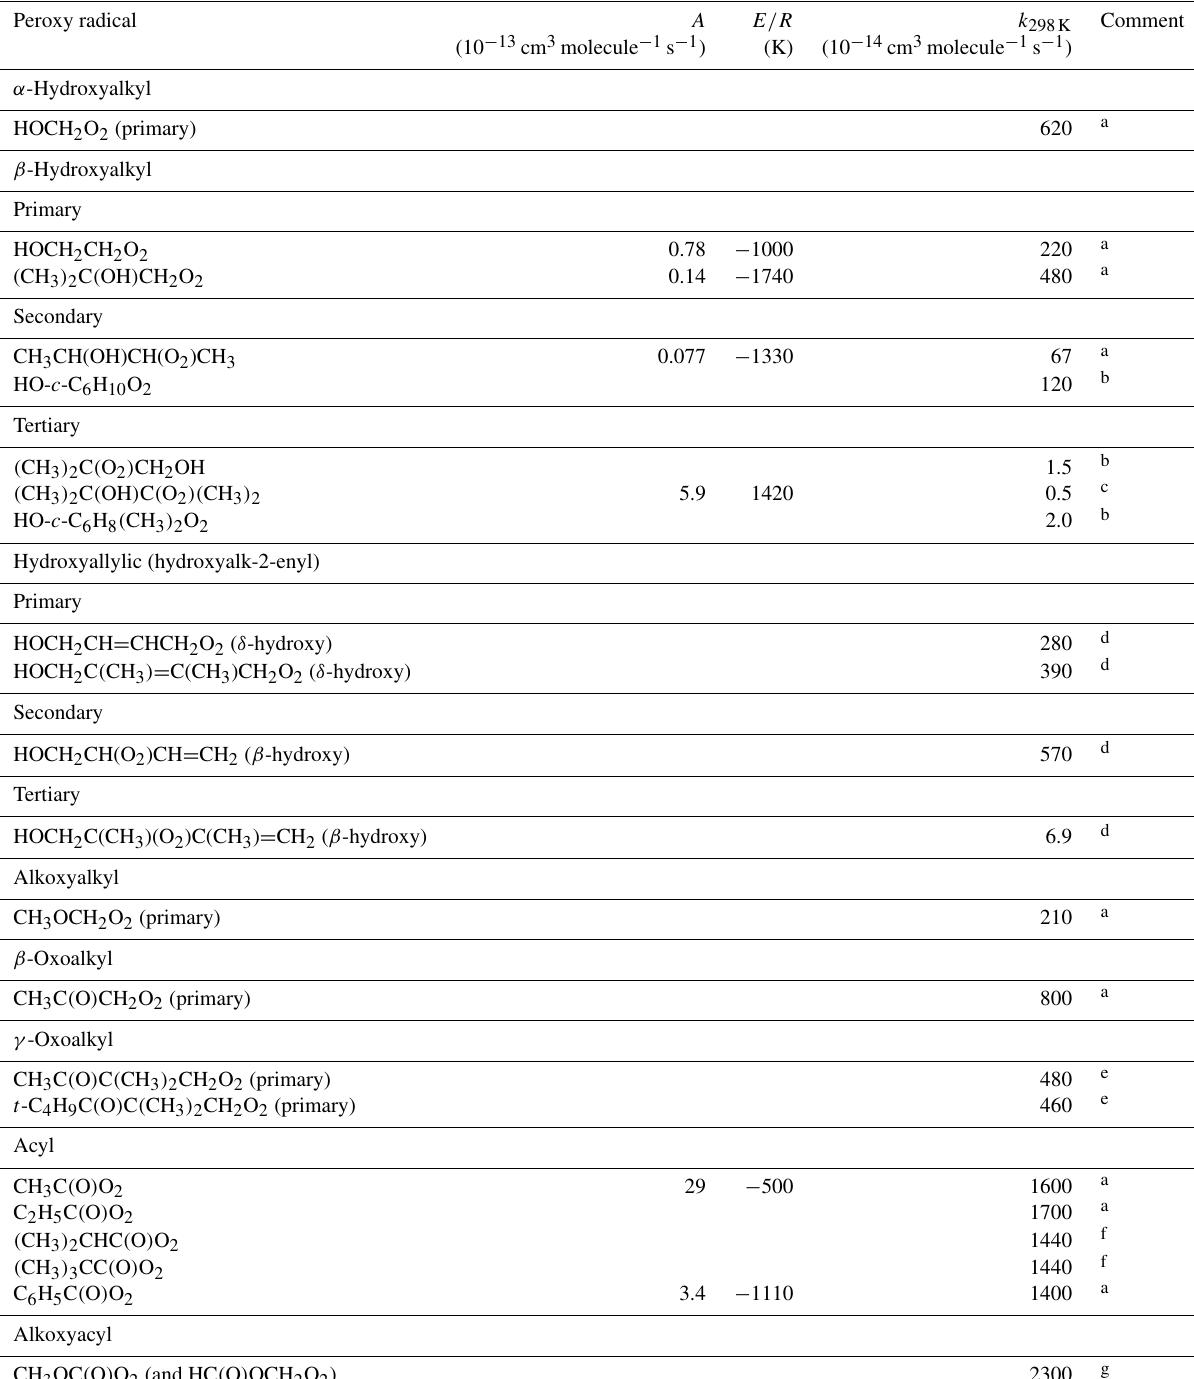
Table 10. Kinetic data for the self-reactions of oxygenated peroxy radicals. Where available, the temperature dependence is given by k = A exp ( − E/RT )